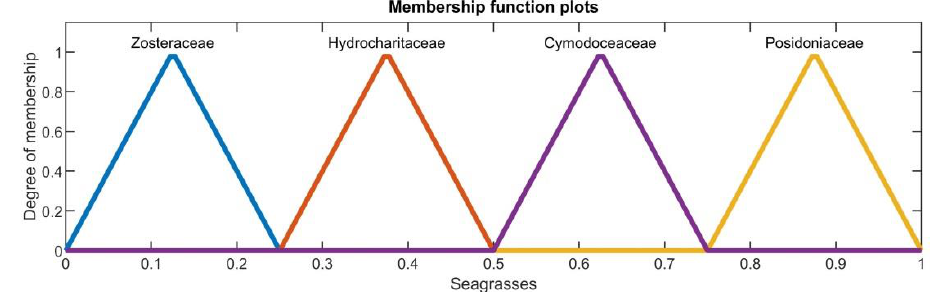
Figure 4. Triangular membership functions for the fuzzy sets of the Seagrass Family, exported from the FIS.